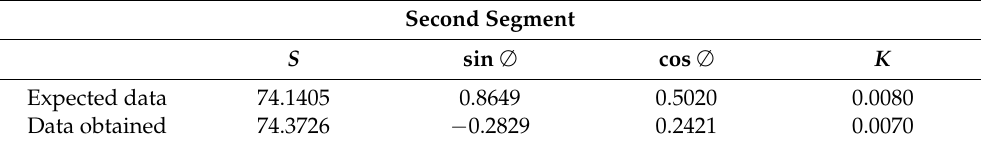
Table 6. Comparison of the neural network results for the second segment. Source: authors. Second Segment S sin